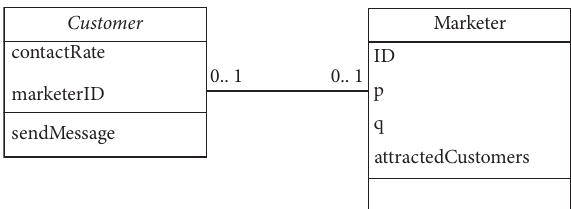
Figure 14: Class diagram for Bass diffusion model developed by OAF.